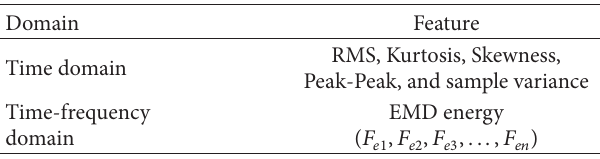
Table 1: Original features for bearing fault diagnosis and perfor- mance